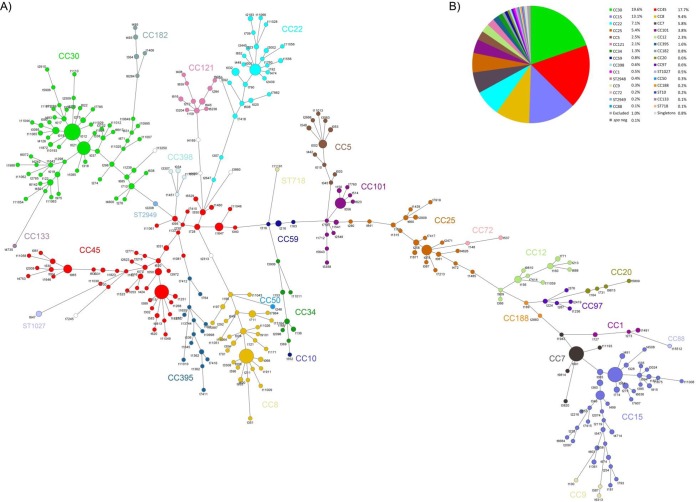
The S. aureus population structure is highly diverse. (A) Minimum spanning tree generated from spa data using the BioNumerics software. Each sphere, or node, represents a unique spa type. The size of each node indicates the number of S. aureus isolates per spa type. The length between two nodes reflects the genetic distance between the two bordering spa types (maximum neighbor distance, 1.00). Nodes are color-coded according the presumptively associated clonal cluster. White circles represent singletons, i.e., strains that were not assigned to any CC. The identification of CCs is based on the BURP algorithm, as implemented in the Ridom StaphType software, aided by MLST sequencing of selected strains. (B) Prevalence of CCs and STs within the SHIP-TREND-0 cohort. spa types marked as excluded were not assigned to clusters, as their repeat sequence included fewer than 5 repeats, and no reliable information about phylogenetic relatedness can be inferred. spa types marked as singletons could not be assigned to a CC. CCs were color-coded in the same manner as in panel A.